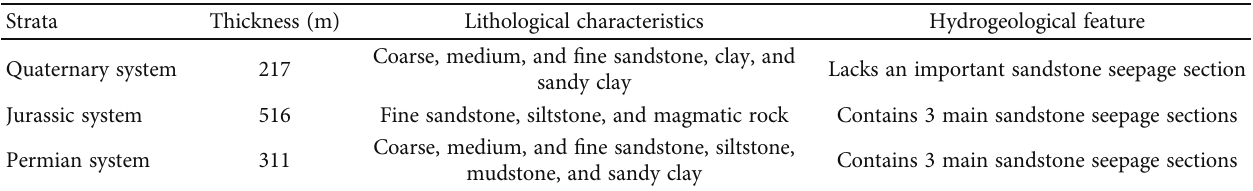
Figure 5: Microscopic changes in the pore structures occurring during the formation process of “ large-area sweating ” seepage in deep mine sandstones. Table 6: List of strata crossed by the ventilating